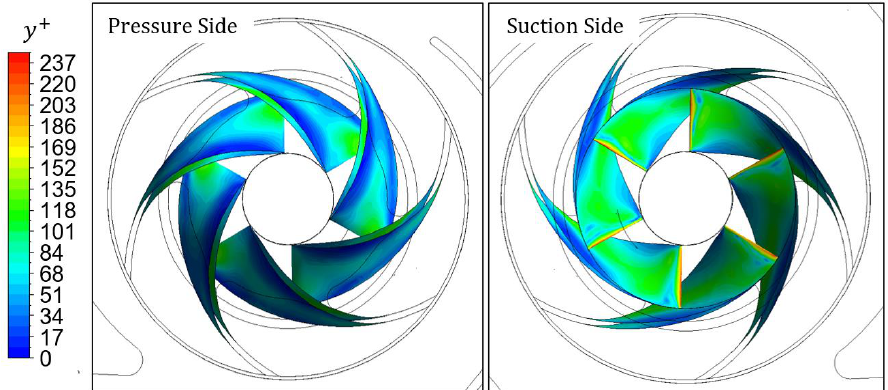
Figure 7. Contour plot of the 𝑦 + distribution on the blade ’s surface.